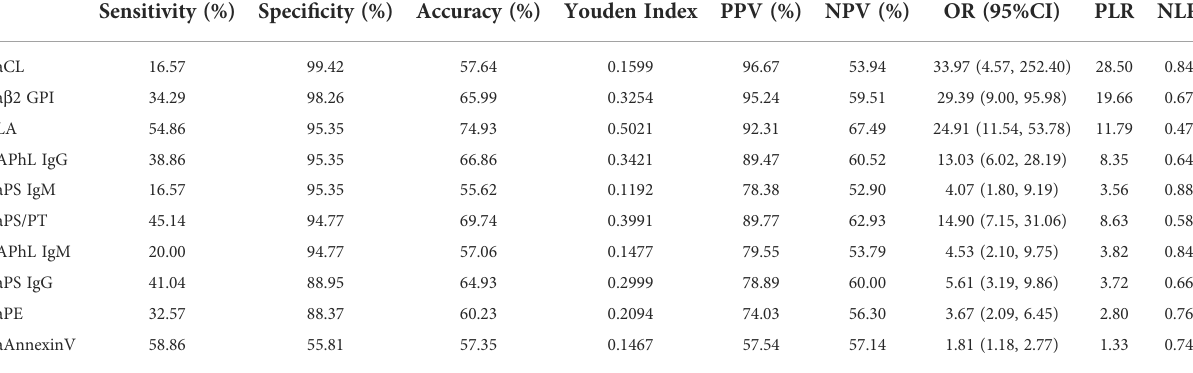
TABLE 3 Diagnostic values of criteria and non-criteria